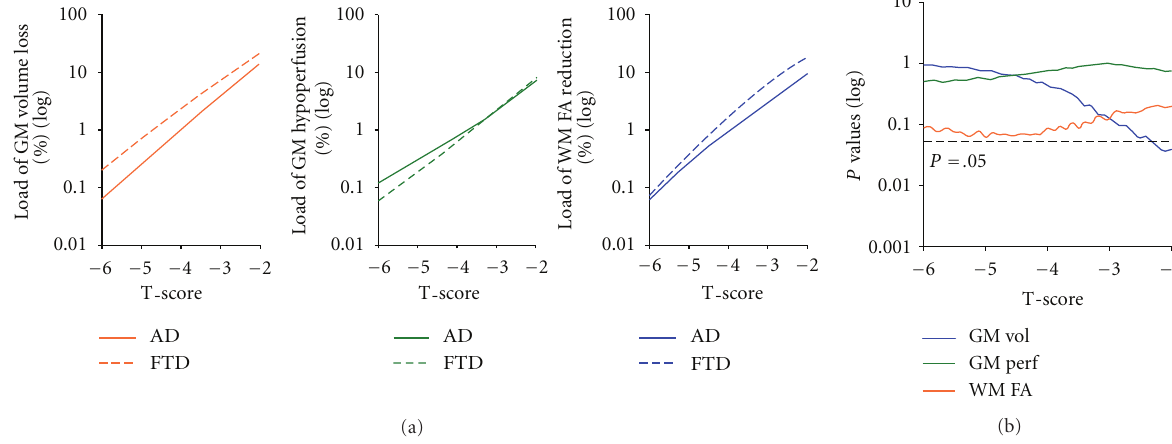
Figure 2: Di ff erences in loads of GM loss (orange lines), GM hypoperfusion (green lines), and reduced WM FA (blue lines) between FTD and AD across a range of T-scores and significant levels. (a) Mean loads of GM loss (I), GM hypoperfusion (II), and reduced WM FA (III) along a range of abnormality levels (T-scores) in AD (solid lines) and FTD (dash lines) patients. (b) Variations in significance of the load di ff erences between FTD and AD as a function of T-scores. Note, the vertical axis of all plots in (a, b) uses a base-10 logarithmic scale. The horizontal dotted line indicates P = . 05